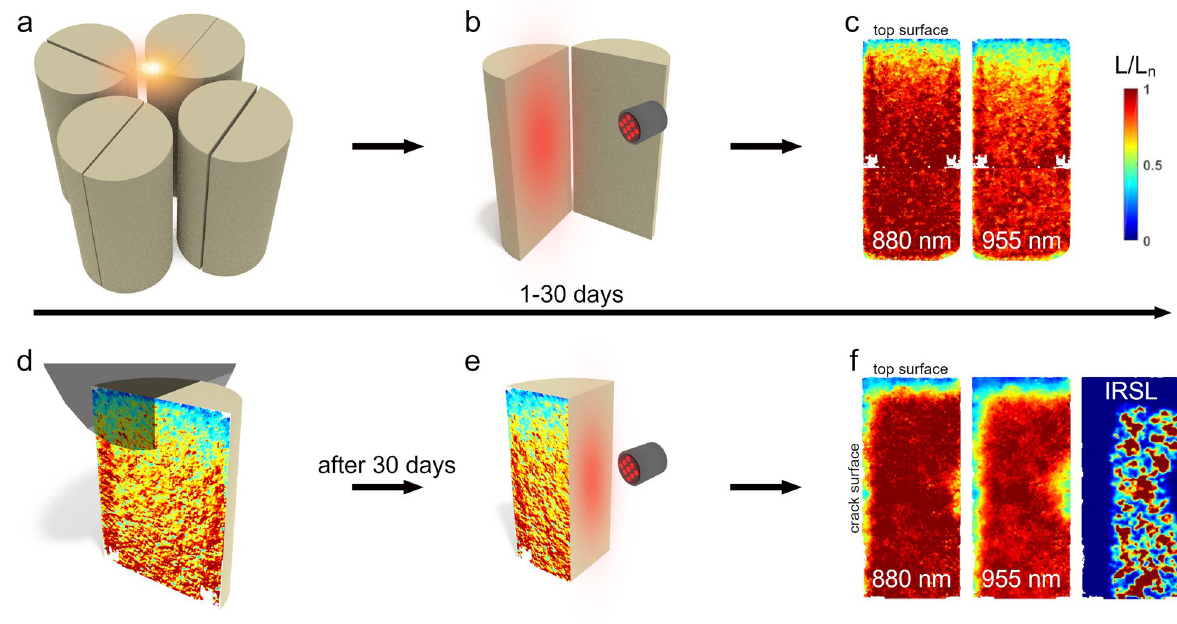
Figure 1. Schematic presentation of the measurement procedure. ( a ) Four artificially cracked cores positioned tightly under a solar simulator. ( b ) IRPL imaging of the inner crack surface during a period of 1–30 days. ( c ) IRPL 880 and IRPL 955 ratio maps of the crack surface for a 0.05 mm crack width after 10 days of illumination. ( d ) Schematic representation of the cutting of a core half perpendicular to the crack surface, after 30 days of illumination. ( e ) IRPL imaging of the perpendicular cut surface. ( f ) IRPL 880 , IRPL 955 and IRSL ratio maps of the perpendicular cut surface for a 1 mm crack after 30 days of illumination. Identical scale bar as in ( c